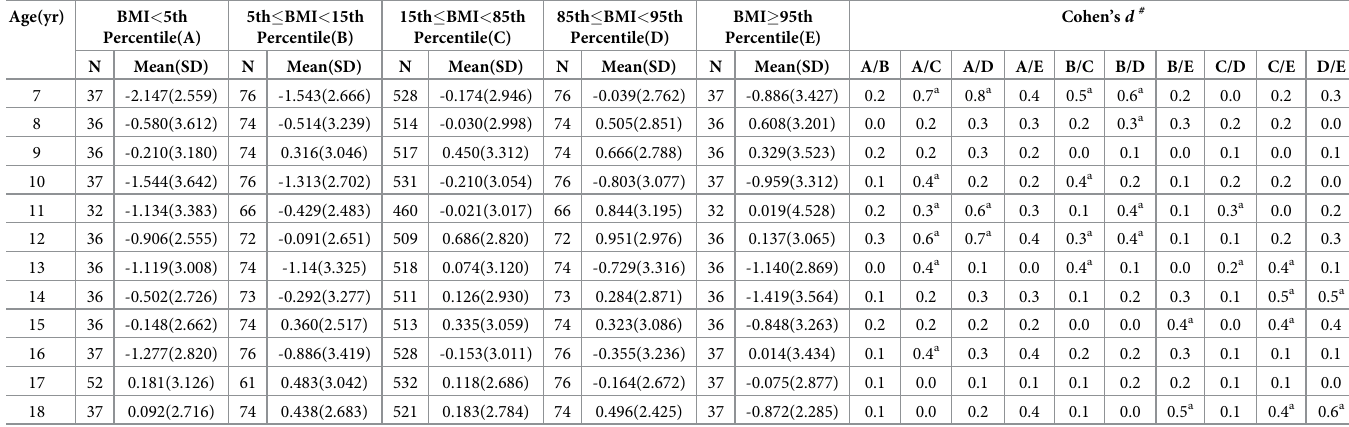
Table 4. Comparisons of physical fitness index among girls in different body mass index and age